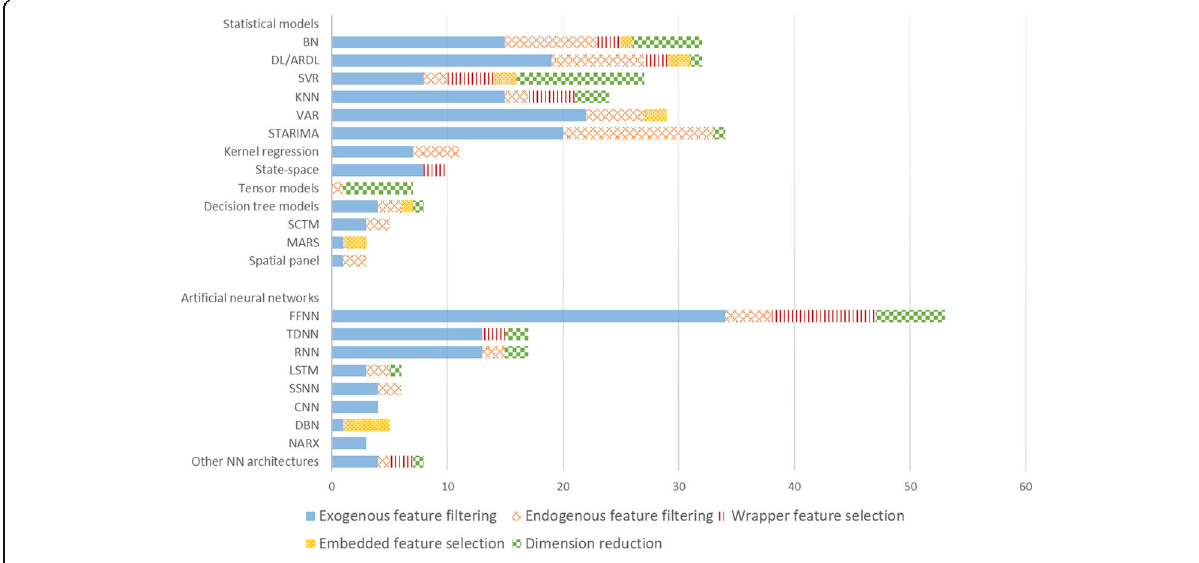
Fig. 6 Coverage of methodologies by FSE